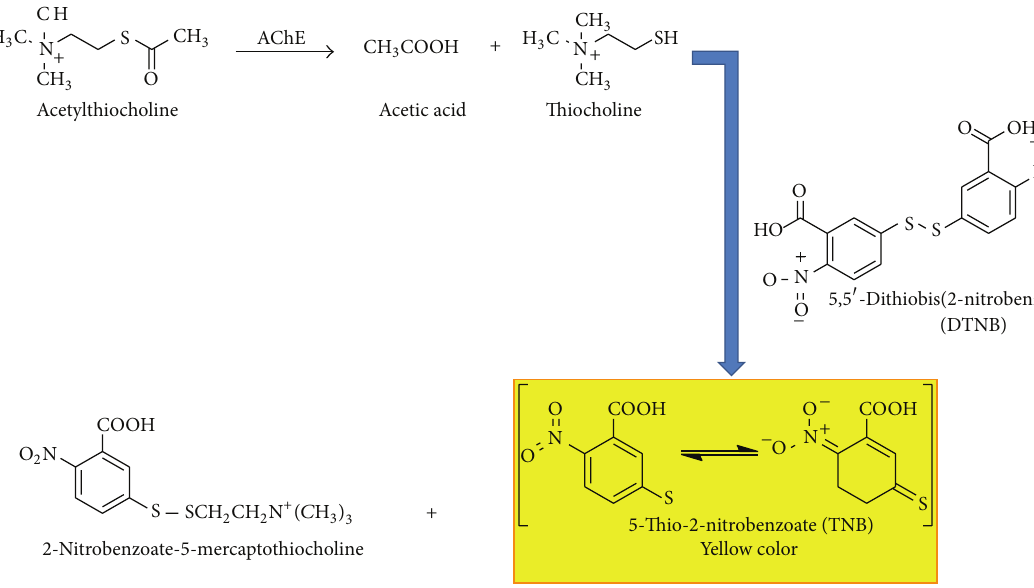
(75 mM) substrate solution was added and the absorbance was recorded at 412 nm. Assays in the absence of inhibitor and in the absence of enzyme-inhibitor (blank) served as